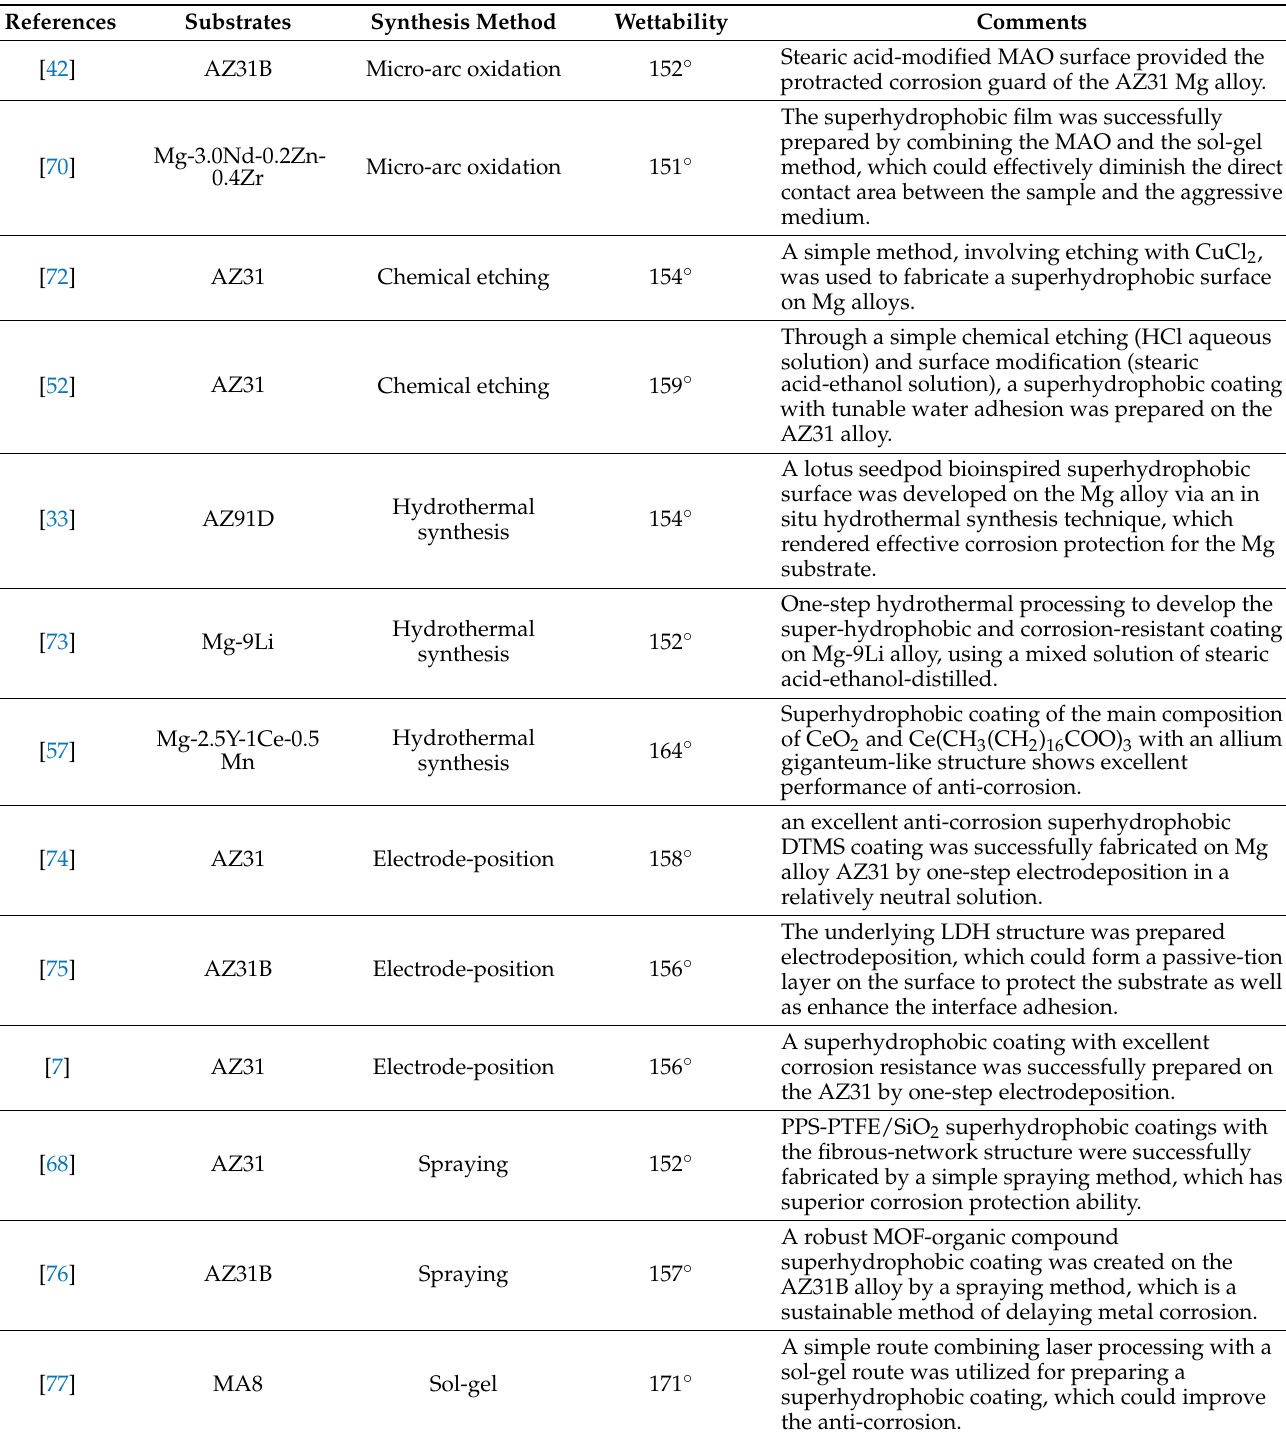
Table 1. Synthesis of superhydrophobic coatings on Mg alloys by various preparation